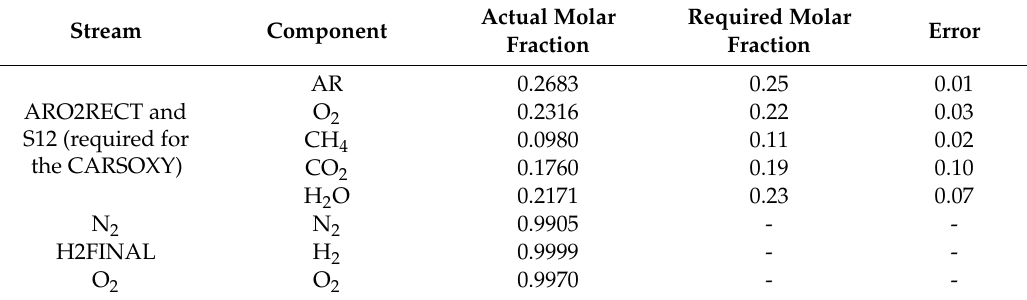
Table 4. CARSOXY final molar fraction.